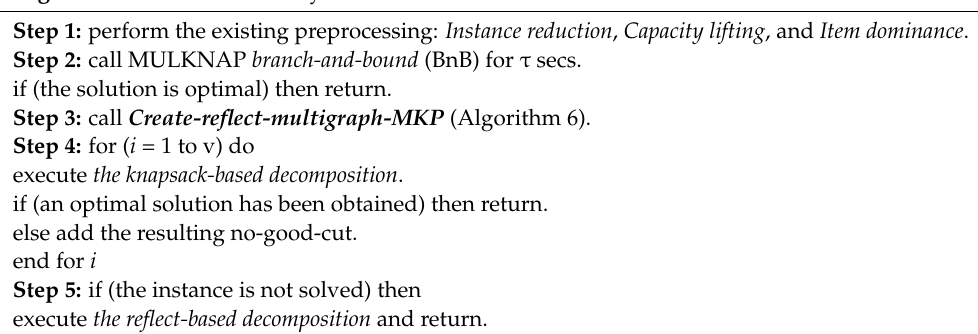
Algorithm 5: Mathematical HyMKP